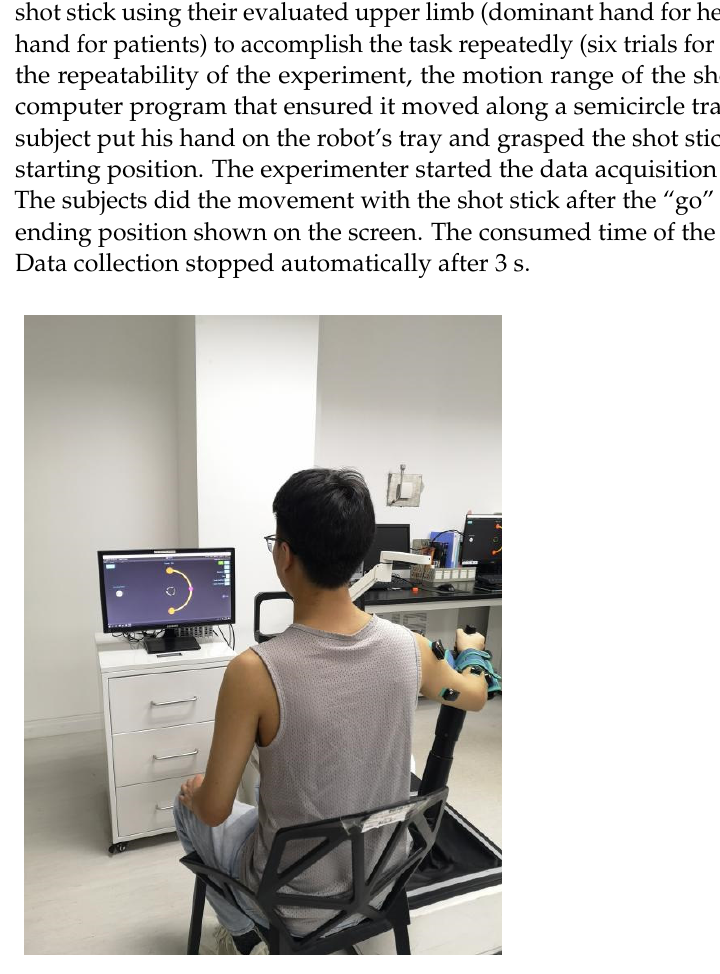
Figure 2. Raw EMG data recorded during the trial of one healthy subject. The unit of the Y coordi- nate is V. 3. Methodology 3.1. NMF NMF, which was first proposed by Lee and Seung [35,36], is usually used to reduce data dimension. Because of its nonnegative constraint, NMF is also applied to analyze medical [43] and space object [44] data. NMF is the most widely used muscle synergy extraction method [15–21], which is usually based on the multiplicative update rules [36]. After creation of the random initial matrices ( C and S ), the iteration is to minimize the Frobenius norm of the residual matrix (preprocessed EMG matrix D minus multiplication of the matrix S and C ) illustrated by Equation (4). The stop criterion is set based on the parameter Q, the percentage of change in the lack of fit between two iterations ( f l ( S , C ) and f l +1 ( S , C )), which is obtained through